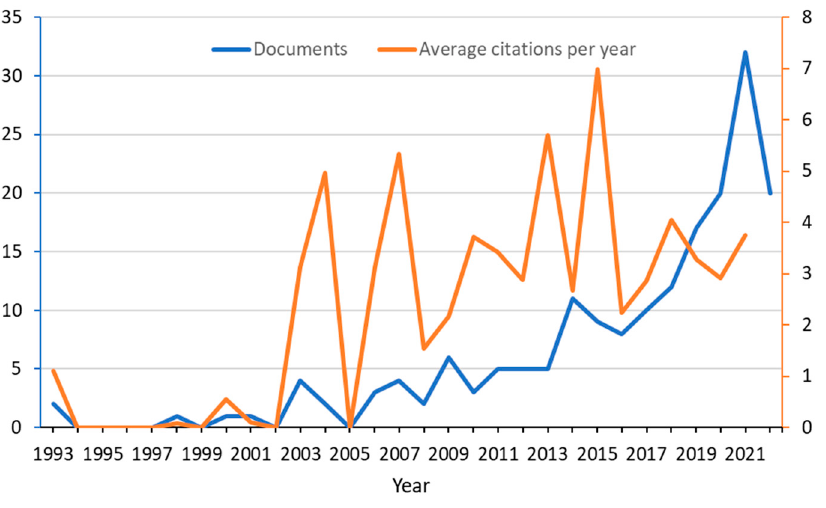
Figure 1. Evolution of the main bibliographic indices, number of documents (blue), and average number of citations per year (orange).